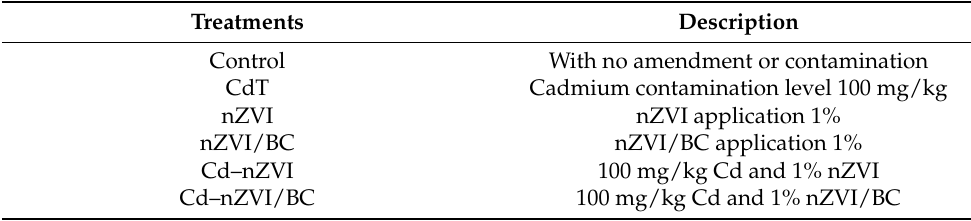
Table 3. Experimental setup and